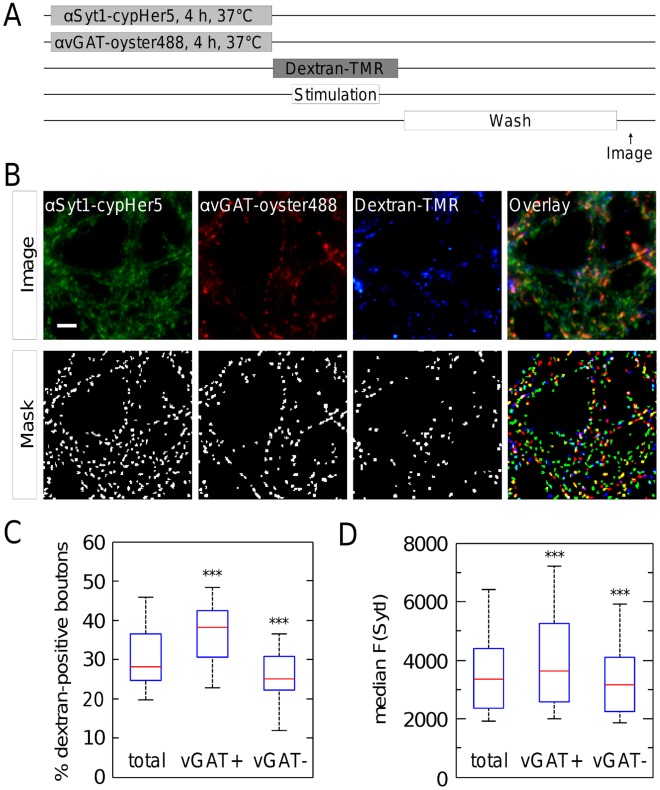
Inhibitory synapses preferentially form bulk endosomes and are slightly larger as compared to excitatory synapses.(A) Experimental procedure. Functional synapses of rat hippocampal neurons were fluorescently labelled with αSyt1-cypHer5. In parallel, inhibitory synapses were identified with an anti-vGAT (vesicular GABA transporter) antibody, labelled with the green fluorescent dye Oyster488®. The cells were then electrically stimulated with 1200 AP, 40 Hz in the presence of 50 µM dextran-TMR. (B) Representative images of αSyt1-cypHer5 and anti-vGAT-oyster488® antibody-stained hippocampal neurons that were exposed to dextran-TMR during the electrical stimulation (“image”). Quantification was done by a Laplace operator based peak-detection (“mask”). (C) vGAT-positive synapses showed a larger percentage of dextran-TMR-staining than vGAT-negative ones or the total of synapses. The boxplot indicates median (red line), 25th and 75th percentiles (blue box) and extreme values (whiskers). Wilcoxon signed rank test, ***p<0.001. N = 4 experiments with 4 to 7 fields of view each; (D) vGAT-positive synapses were larger than vGAT-negative ones or the total of synapses.